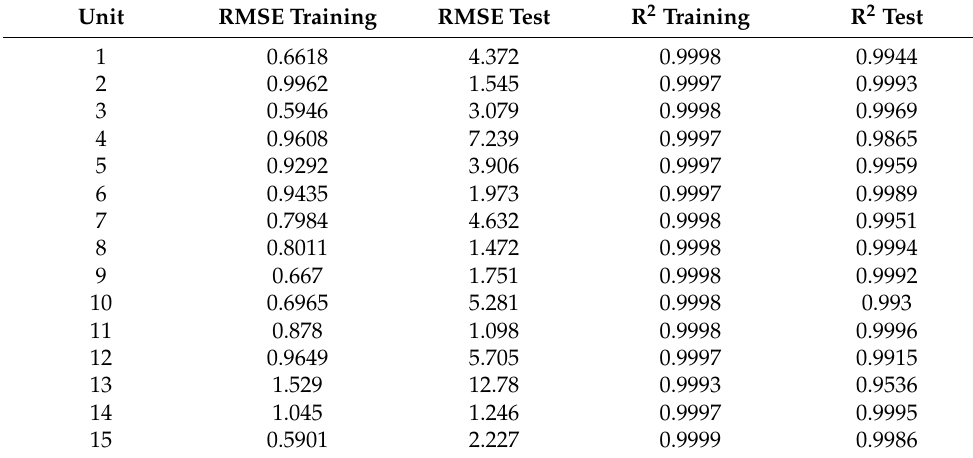
Table 6. RMSE and R 2 per unit for DS08a. Unit RMSE Training RMSE